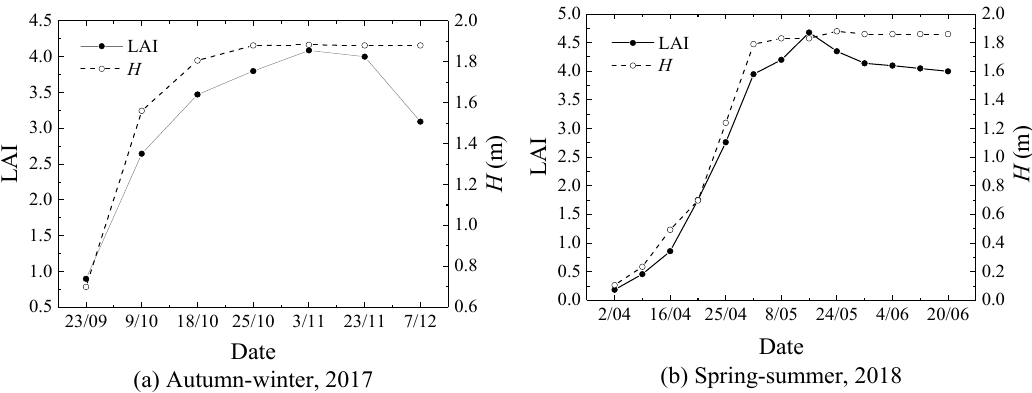
Figure 4. Evolution of plant height ( H ) and leaf area index (LAI) during cucumber growth in 2017 ( a ) and 2018 ( b ). The transplanting and harvesting dates were 3 September and 12 December in 2017, respectively, and 23 March and 29 June in 2018, respectively.